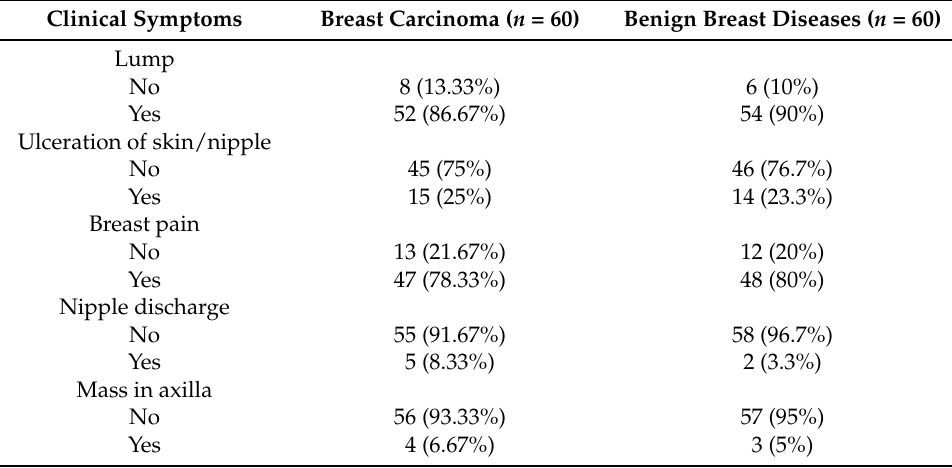
Table 1. Clinical profile of patients with breast carcinoma and benign breast diseases.